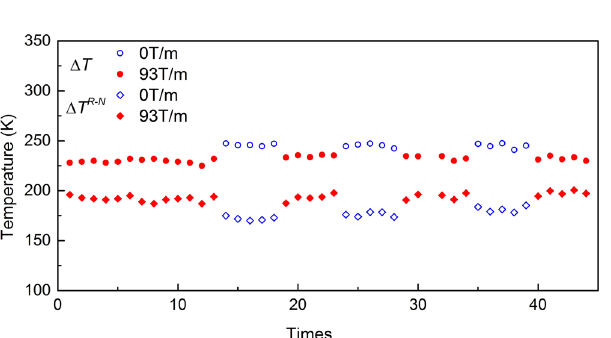
Figure 4. Undercoolings of Co 76 Sn 24 near eutectic alloy measured in alternately magnetic gradient